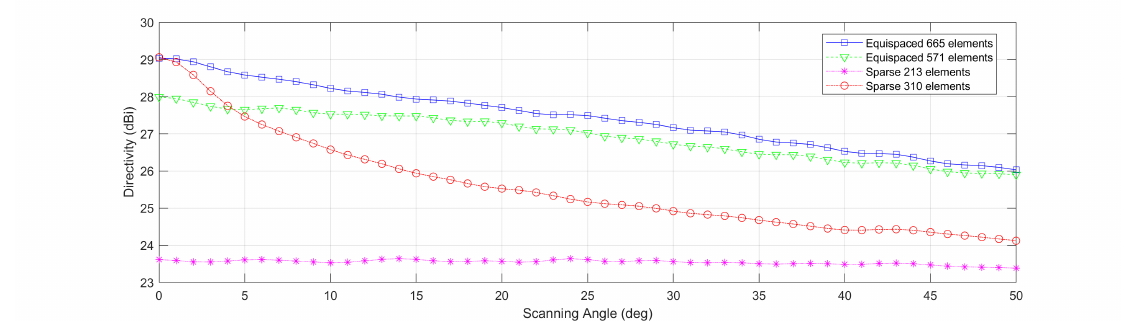
Figure 7. Directivity as a function of the focusing angle for some of the synthesized array